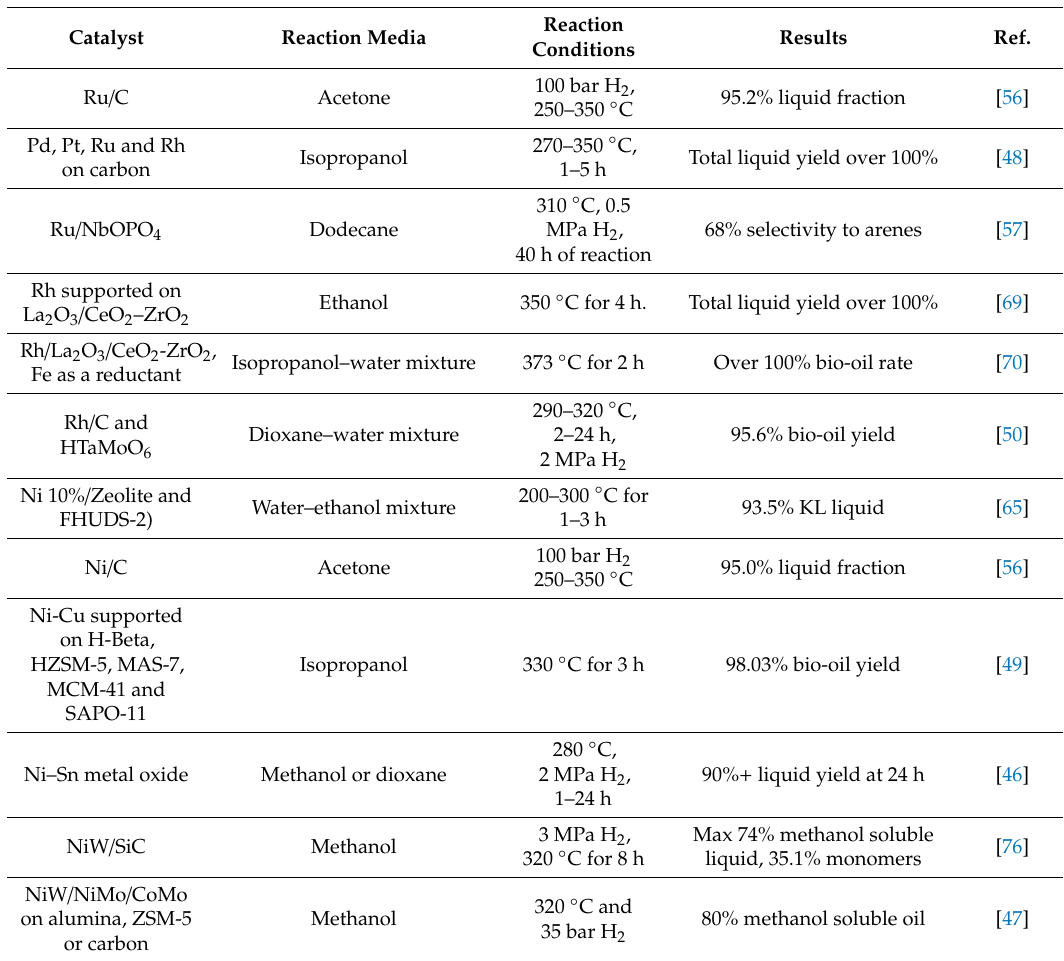
Table 3. Bio-oil yields and products obtained from di ff erent solvothermal studies, ordered on the basis of the catalyst